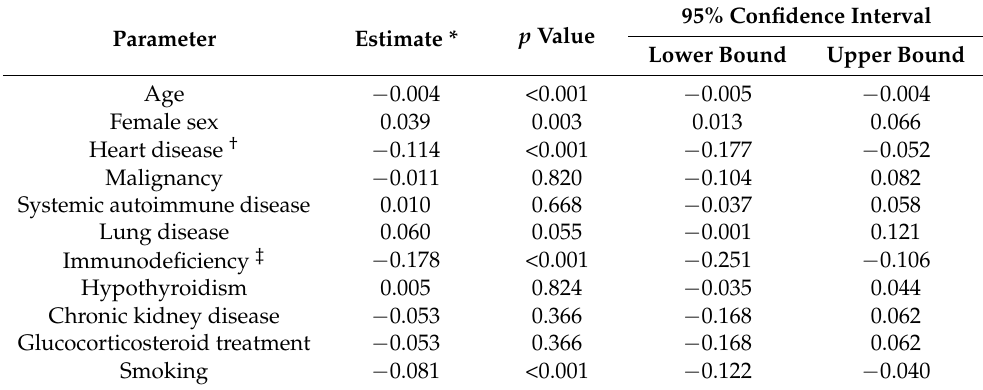
Age = random effect. * Estimate represents the statistical importance of fixed-effects coefficient parameters and the slope between the dependent and predictor parameters. † Heart disease includes ischemic heart disease and congestive heart disease. ‡ Immunosuppressive therapy other than gluococorticosteroids during the last six